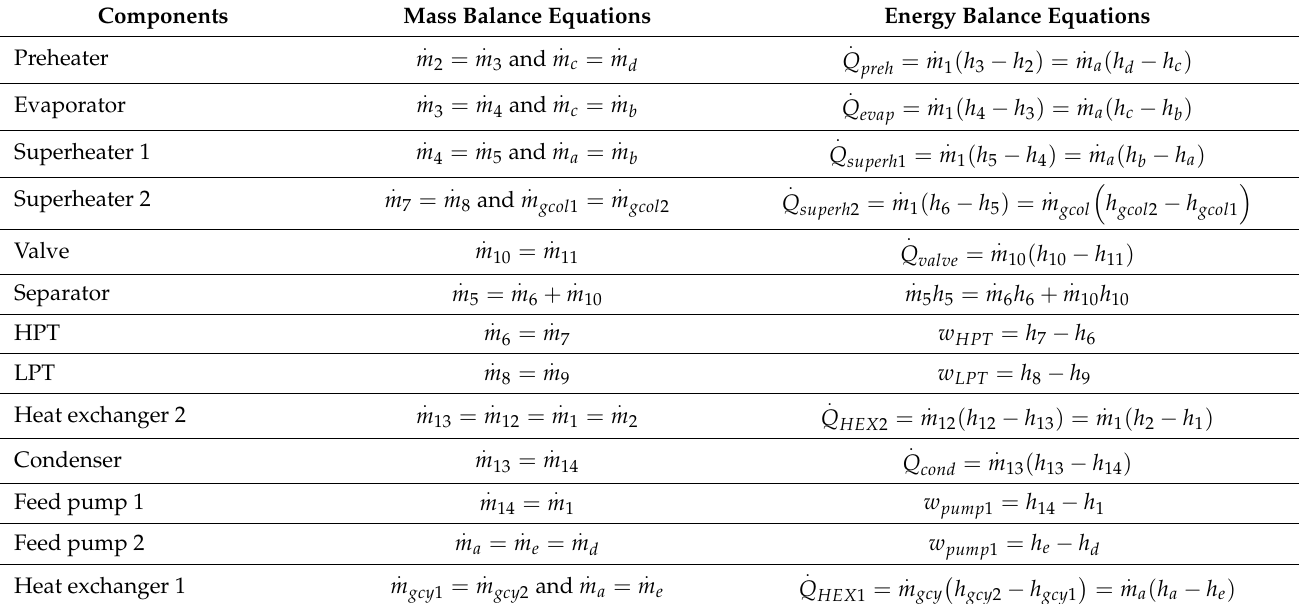
Table 4. Mass and energy balance of KCC